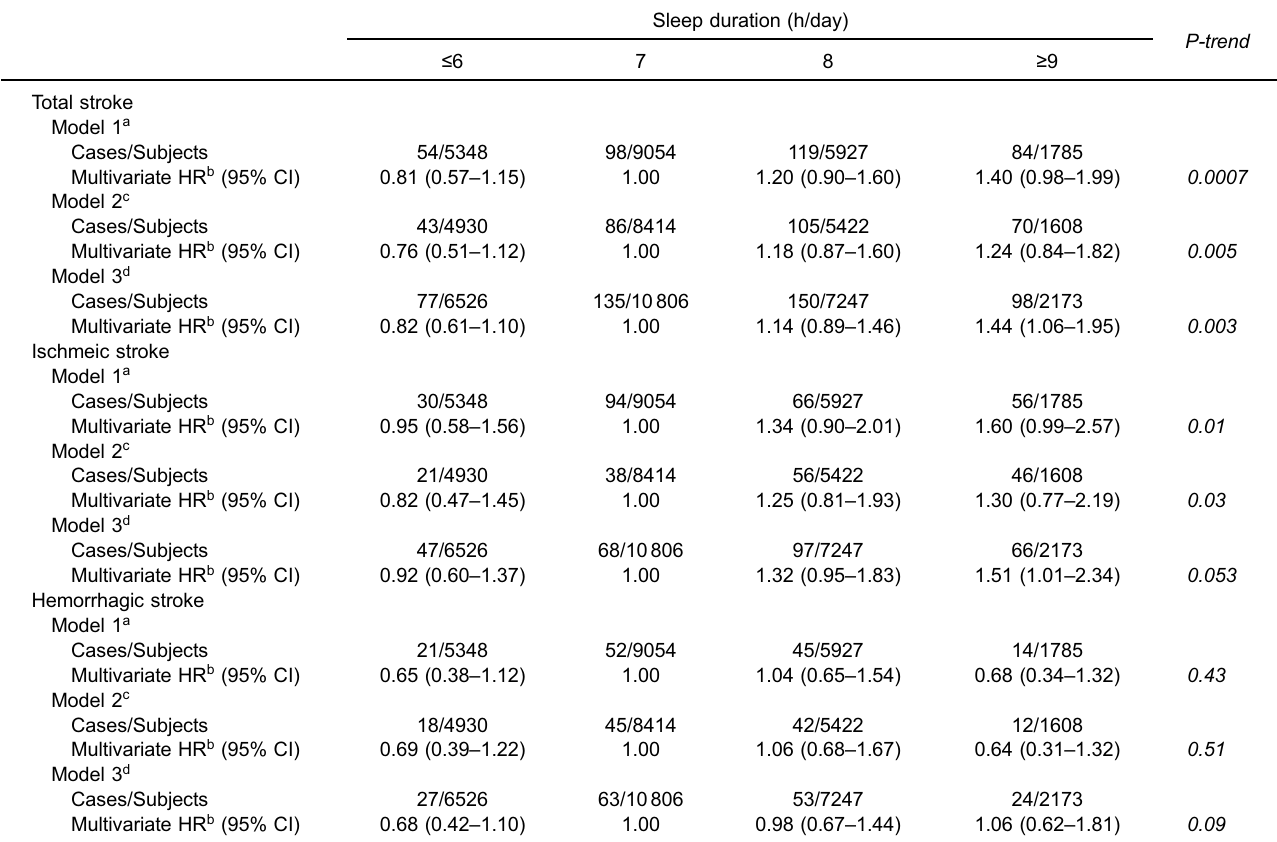
Table 3. Sensitivity analyses of the associations between sleep duration and the risk of mortality from stroke Sleep duration